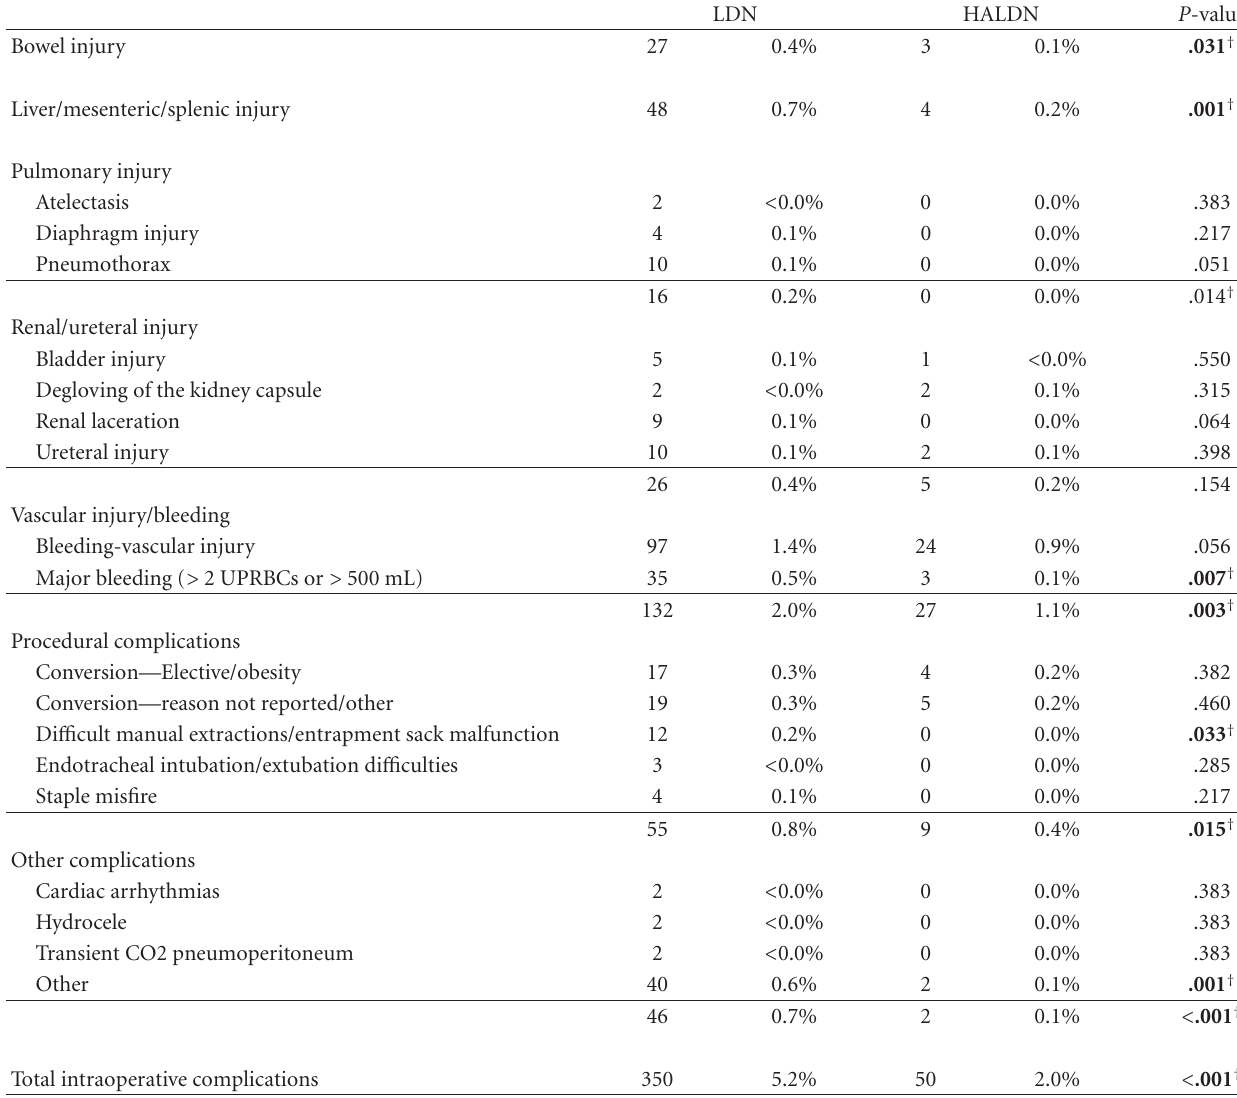
Table 2: Intraoperative complications of LDN and